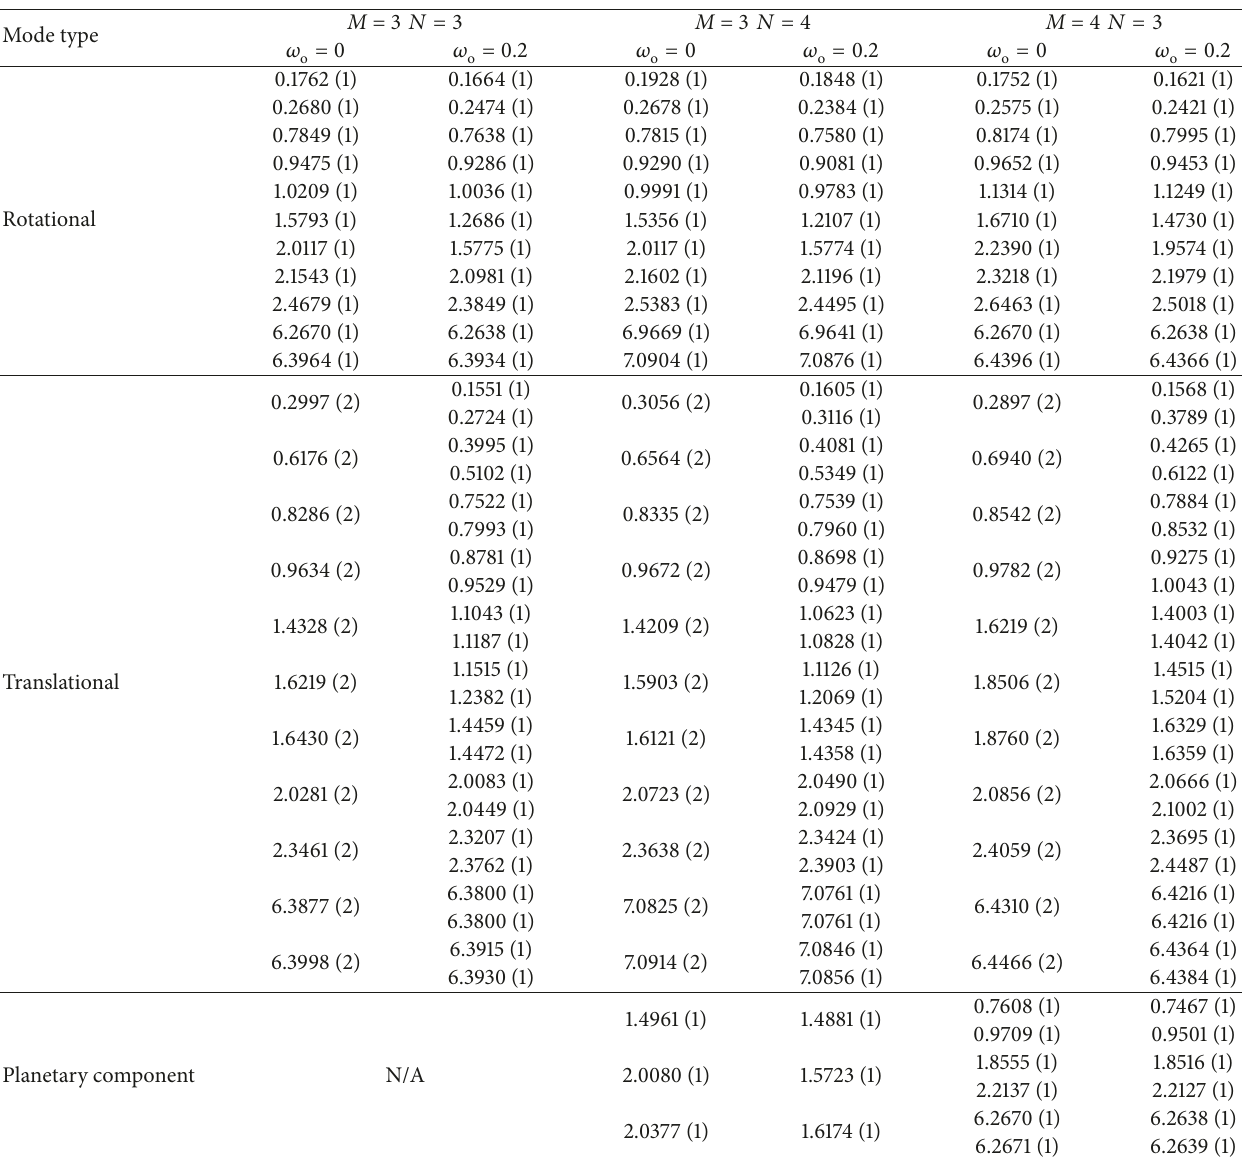
Table 3: Nondimensional natural frequencies (Hz) and Im (𝜆) , for RV